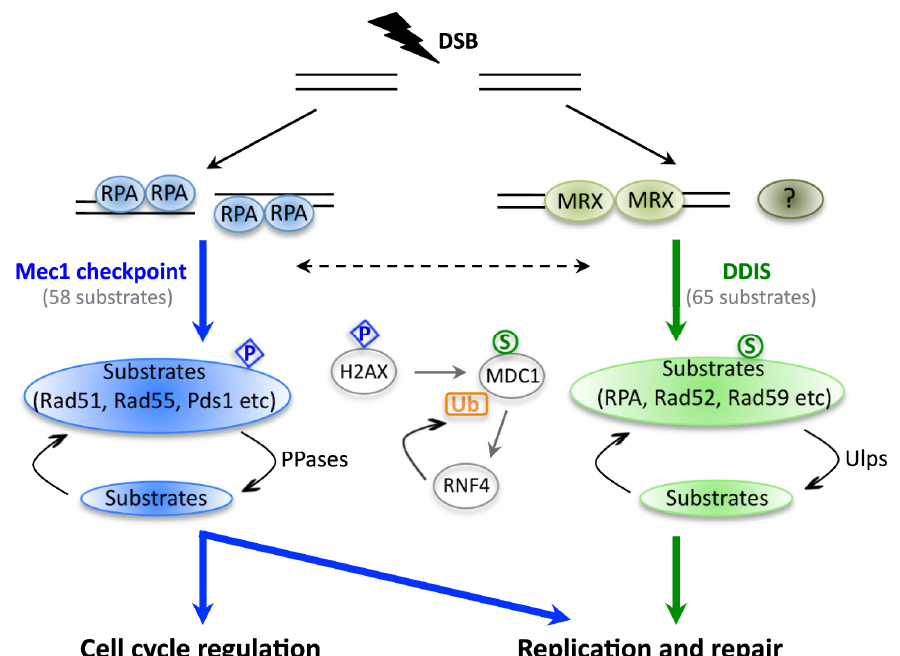
Figure 2. Simplified scheme showing DDIS and its possible integration within the response to DNA damage, such as DSBs. Components of the checkpoint and sumoylation responses are colored blue and green respectively. The Mec1 checkpoint is activated by long stretches of RPA-coated ssDNA, whereas MRX and possibly other factors (?) are required for DDIS. For simplicity, the checkpoint contributions of MRX and Tel1 are not depicted. The number of Mec1 checkpoint and DDIS substrates are based on systematic studies in budding yeast under several DNA damage conditions including DSBs [20,38]. P, S and Ub indicate phosphorylation, sumoylation and ubiquitination events, respectively. An example of the interplay between these modifications involving H2AX, MDC1, and RNF4 is shown as described in the text. Grey arrows specify recruitment to